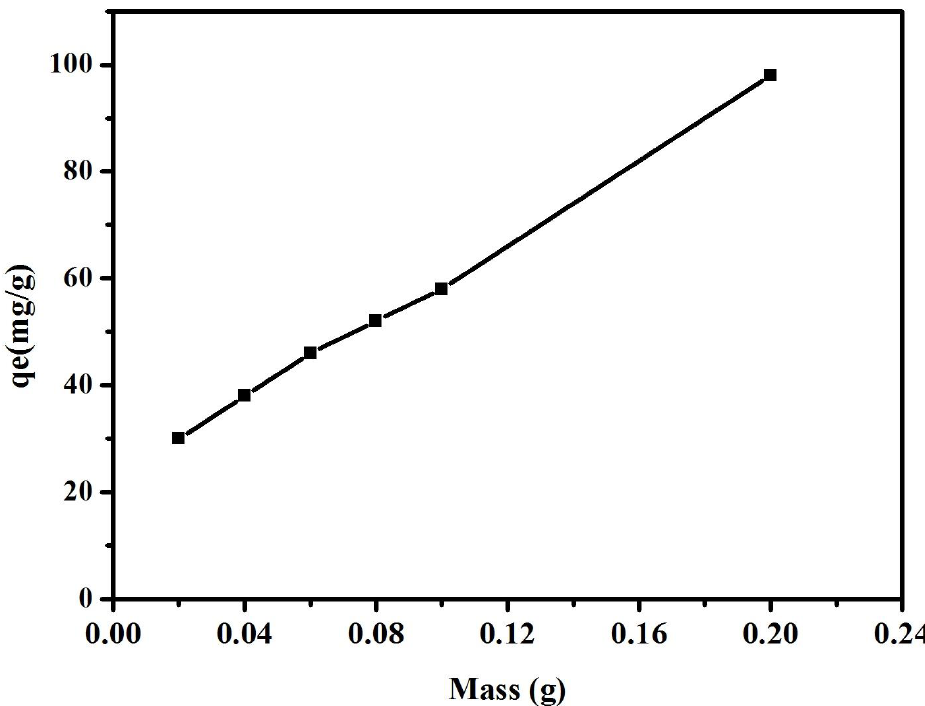
Figure 4. The variation in the amount of methylene blue adsorbed as a function of the mass of Ba 0.54 Na 0.46 Nb 1.29 W 0.37 O 5.